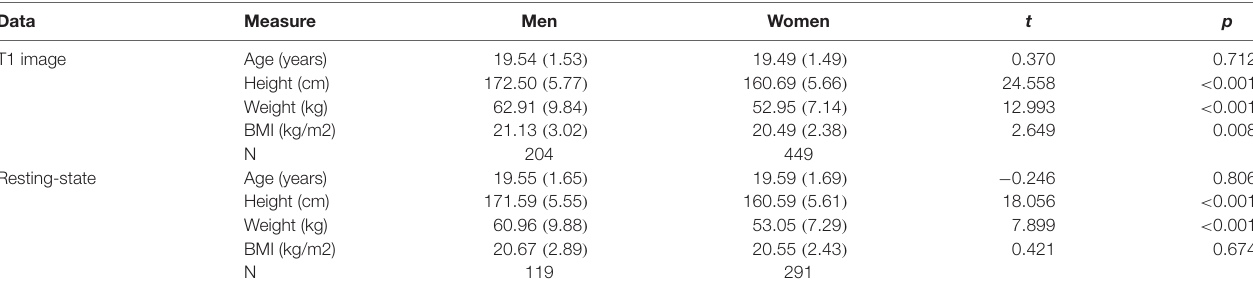
TABLE 1 | Sample characteristics for voxel-based morphometry (VBM) and resting state of our participants.